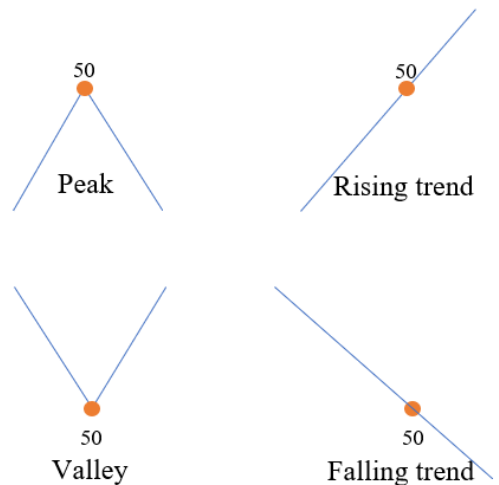
Figure 2. An illustrative example of the four possible trends for any